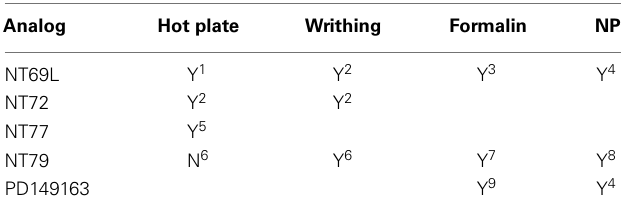
Table 3 |Analgesic effects of NT